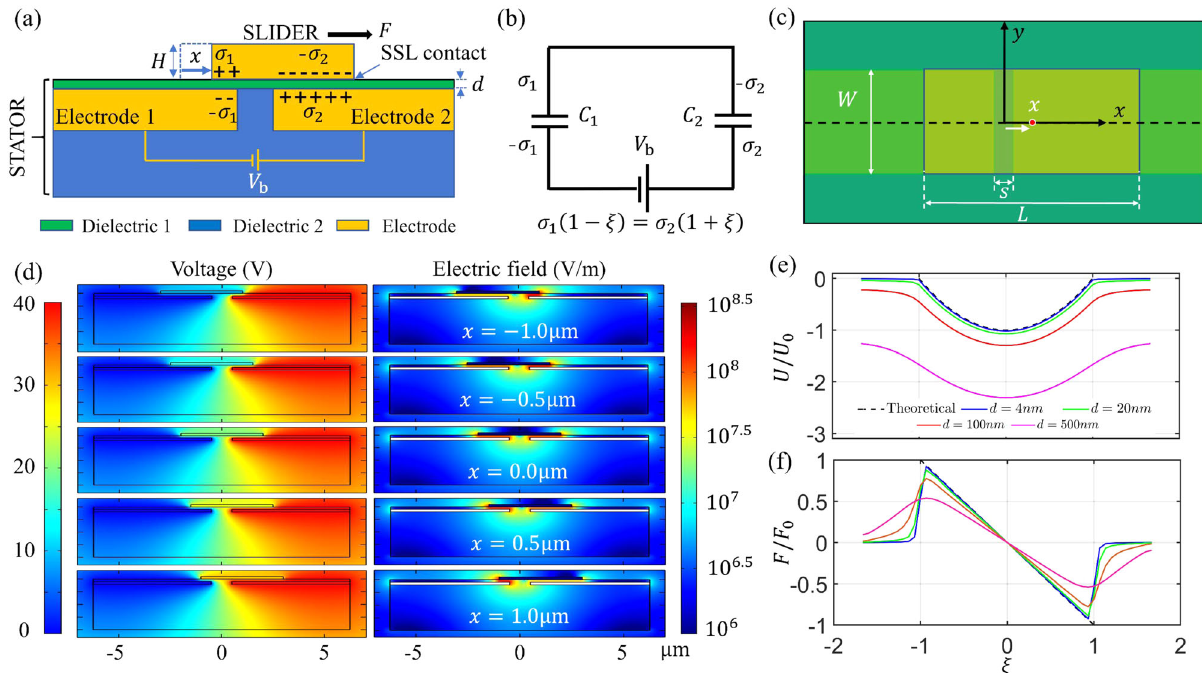
Fig. 1 Elementary structure, driving force of ESL-spring, and its numerical validation. a , c Illustration of ESL-spring viewed from side and top, respectively, where key variables and parameters are indicated. b Equivalent circuit diagram of ESL-spring. d – f are the two-dimensional FEM simulation results for the potential and electric fi elds as functions of sliding displacement of the SLIDER (the upper electrode), with L ¼ W ¼ 4 μ m, H ¼ 200nm ; s ¼ 1 μ m, and V ε : 9 Þ . d Changes in the potential fi eld (left panel) and electric b ¼ 40V, and taking silicon oxide as Dielectrics 1 and 2 ð r ¼ 3 fi eld (right panel) with fi ve symmetrical displacements for d ¼ 100nm : e , f Dimensionless equivalent potential energy and driving force as functions of the relative sliding displacement ξ ¼ 2 x = L c with respect to four different width-thickness ratios, W = d ; the approximation accuracy is excellent for W = d >